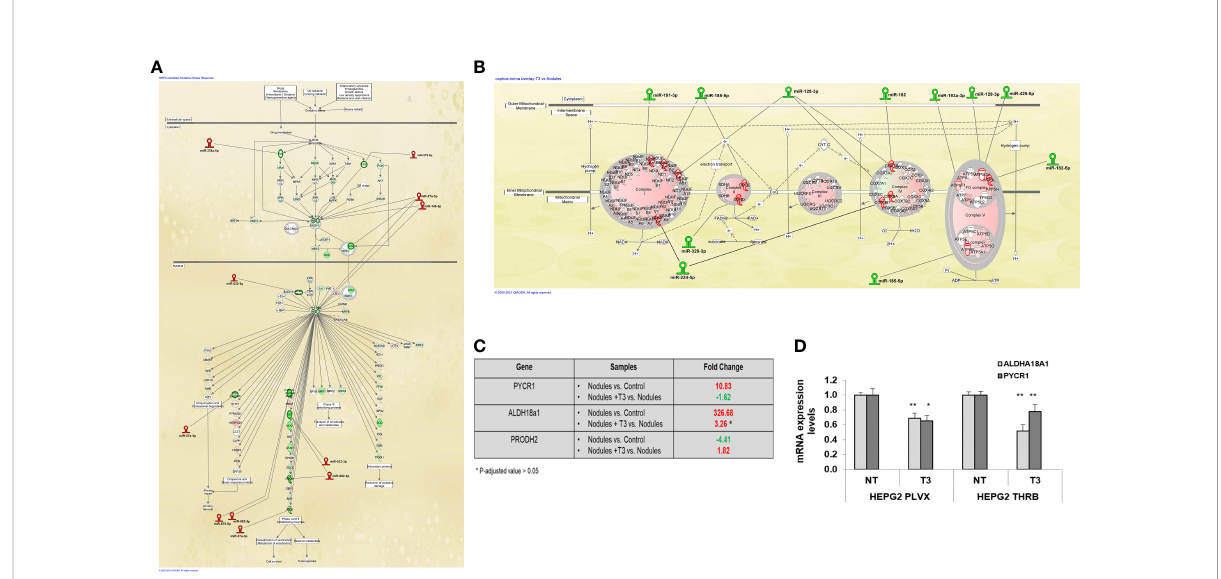
FIGURE 4 MiRNA:mRNA integrated network and proline biosynthesis in preneoplastic nodules following T3 treatment (A) IPA analysis of Nrf2 oxidative stress response pathway in T3 treated nodules vs . untreated nodules; (B) IPA analysis of Oxidative Phosphorylation pathway in T3-treated nodules vs . untreated nodules; (C) Results of NGS analysis showing fold change of the key genes involved in proline metabolism: Pycr1, Aldh18a1 and Prodh2. P -adjusted value = 0.05 and FC ± 1.5; (D) qRT-PCR analysis of the expression of PYCR1 and ALDH18a1 in HepG2 cells not transduced (PLVX) or transduced with THRB and treated (T3) or not (NT) for 48 hours with 100nM T3. MiRNA expression was calculated as fold change using the 2 - DD Ct method and RNU48 as endogenous control. Student t-test: * P < 0.05; ** P <0.01. Values are expressed as mean ±